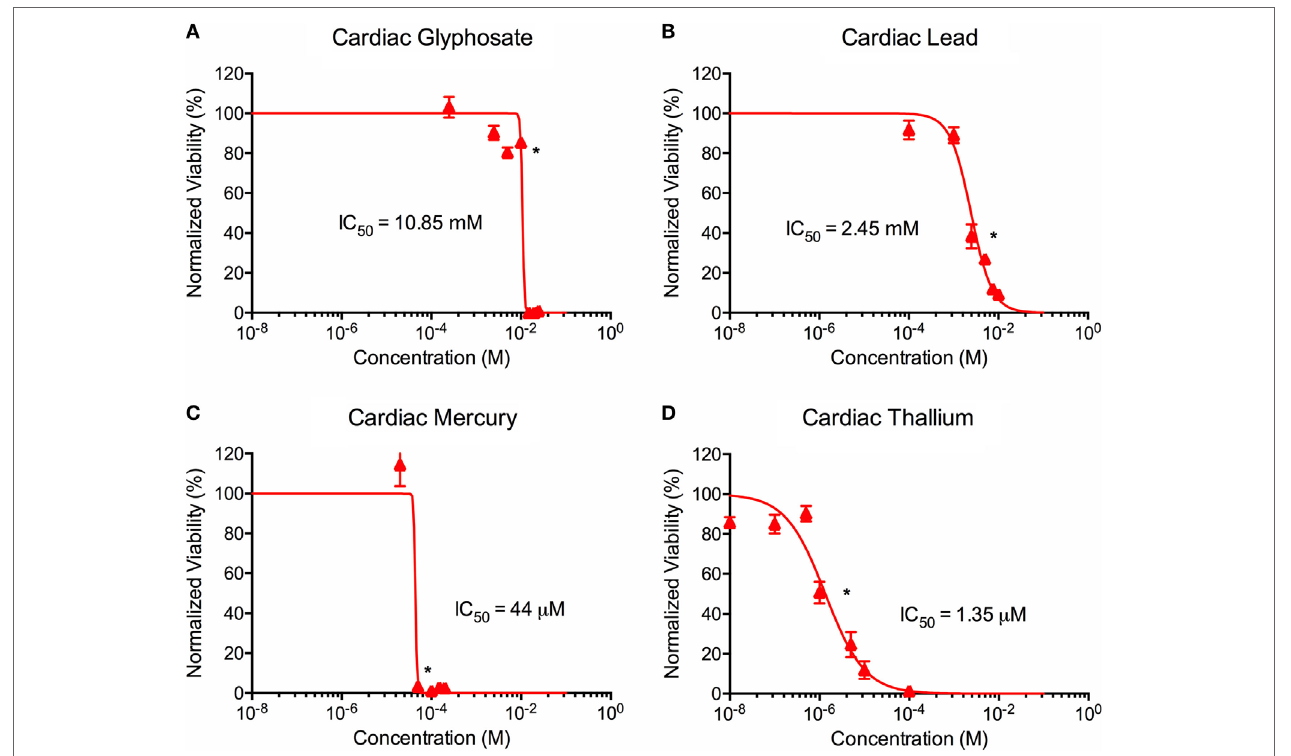
FigUre 4 | Environmental toxin effects on cardiac organoid ATP activity. Survival curves for cardiac organoids exposed to glyphosate (a) , lead (B) , mercury (c) , and thallium (D) over the course of two days. Adjusted ATP activity is a comparison of the ATP value of organoids exposed to toxins over the control cardiac organoids. Statistical significance: * p < 0.01 with bracket encompassing all doses with this value. IC50 value was determined through calculation of line crossing the IC50